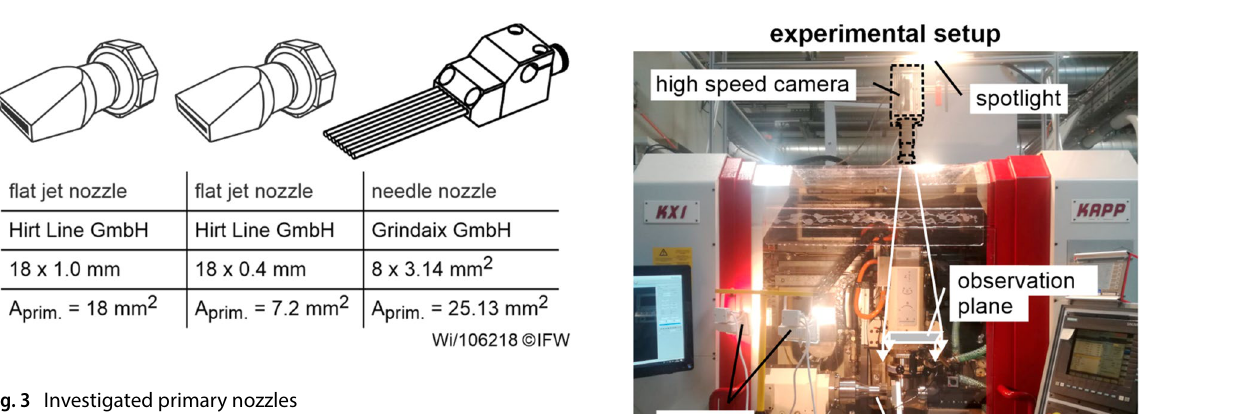
Fig. 3 Investigated primary nozzles